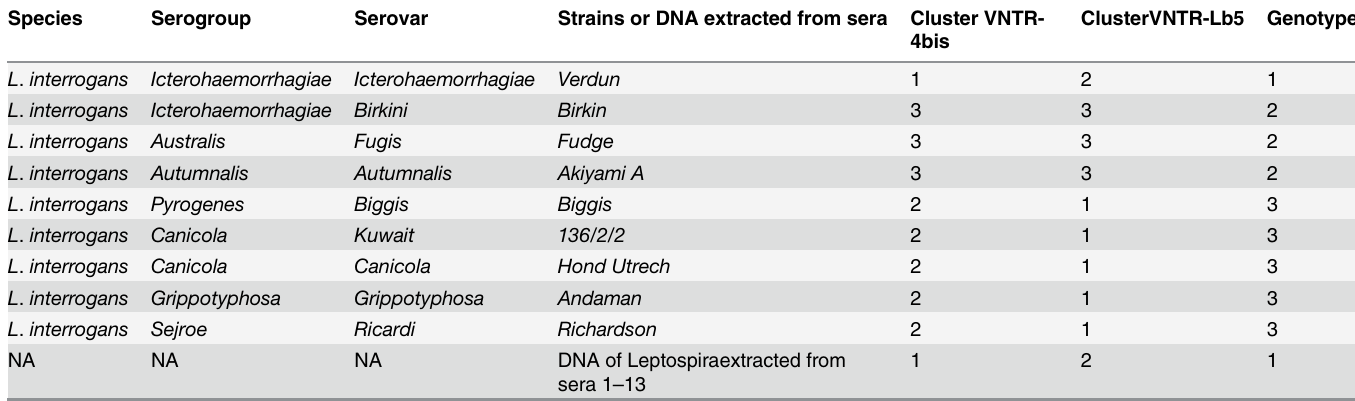
Table 2. Clusters of species and DNA extracted from sera with the VNTR 4bis and Lb5 primers shown in Fig 5. Species